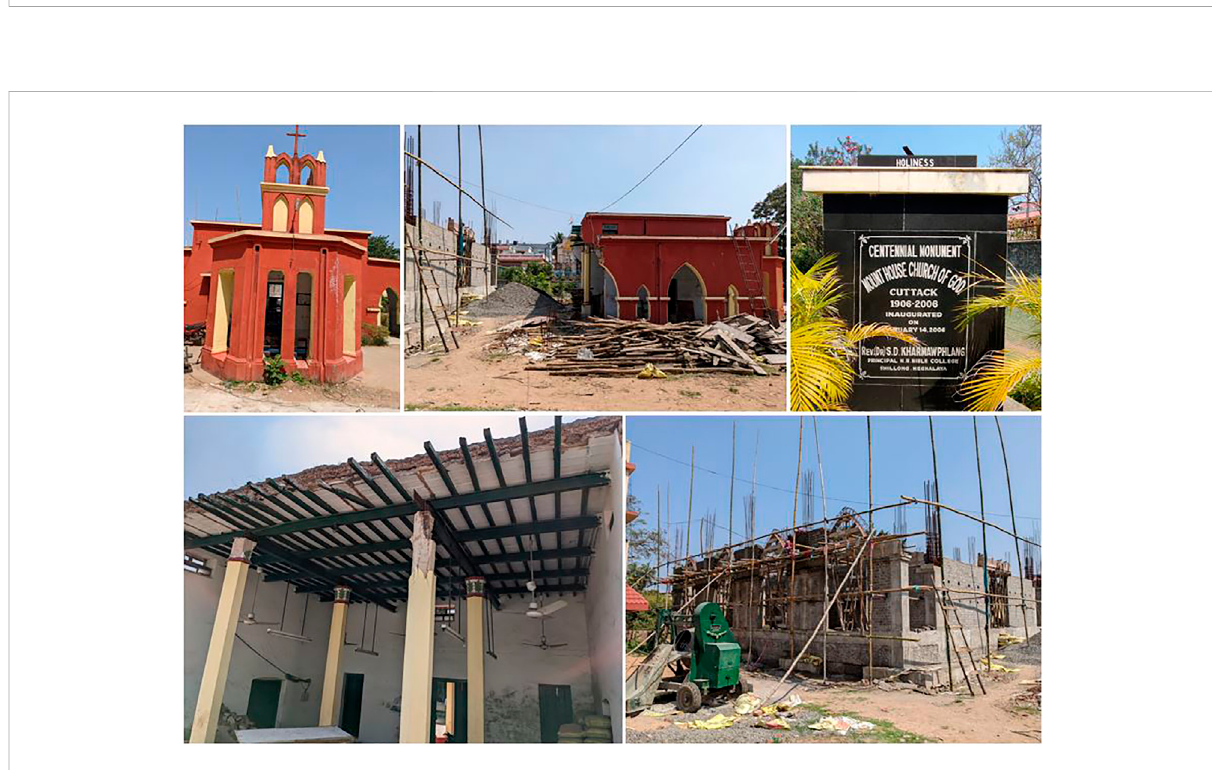
FIGURE 6 Mount House Church of God,